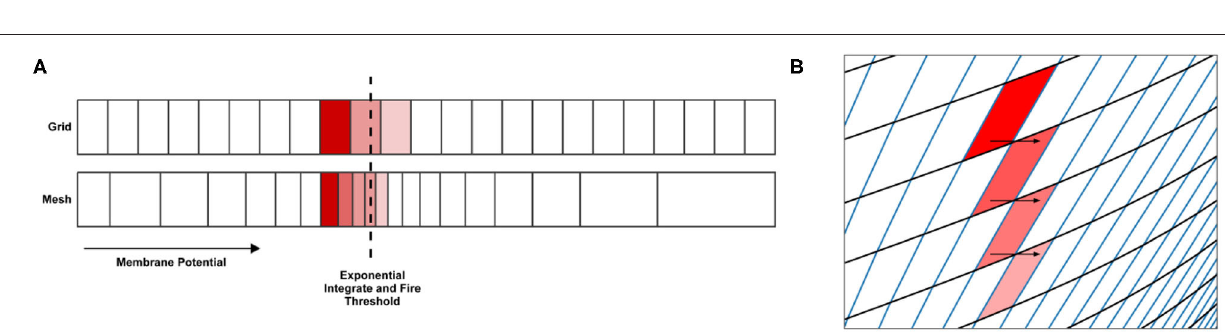
FIGURE 6 | Comparison of average firing rates from four simulations of a single population of conductance based neurons. The black solid and dashed lines indicate MIIND simulations using the grid algorithm with different grid resolutions. The red crosses show the average firing rate of a direct simulation of 10,000 neurons.